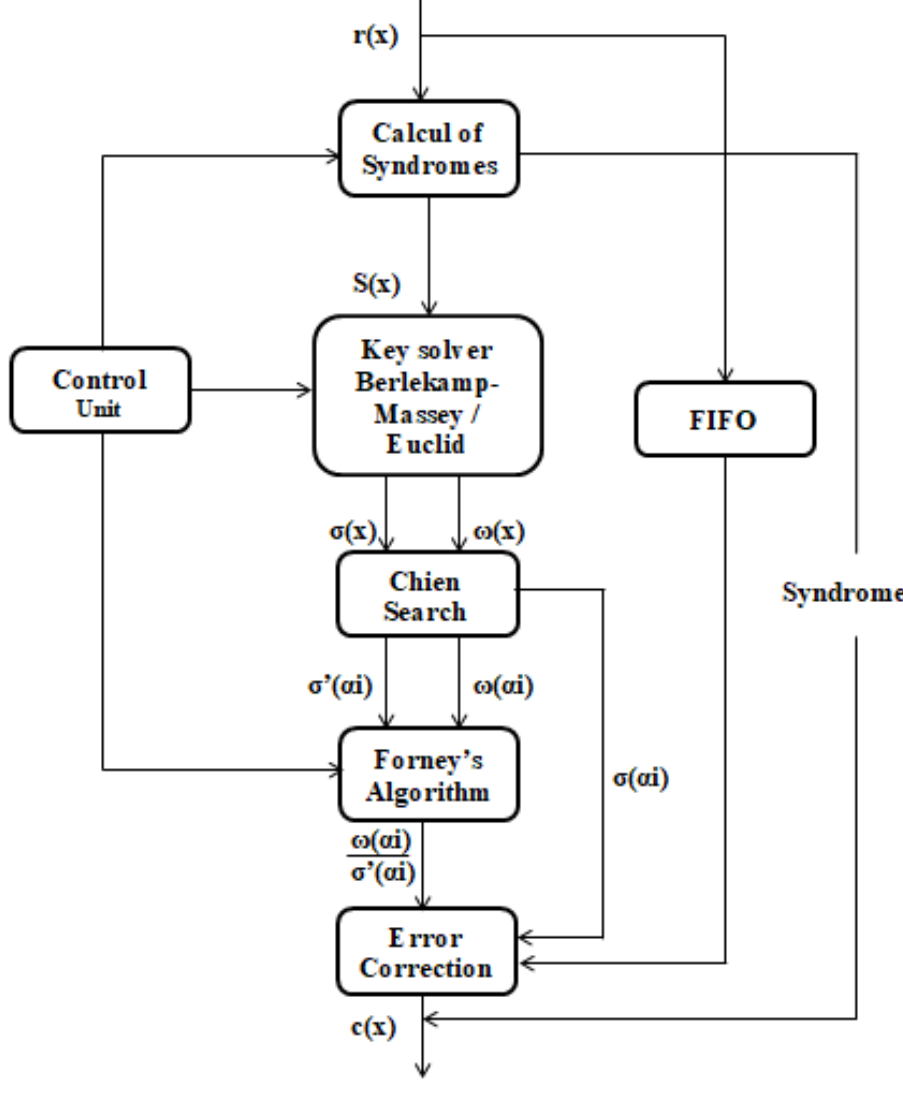
Figure 4. Decoding steps of